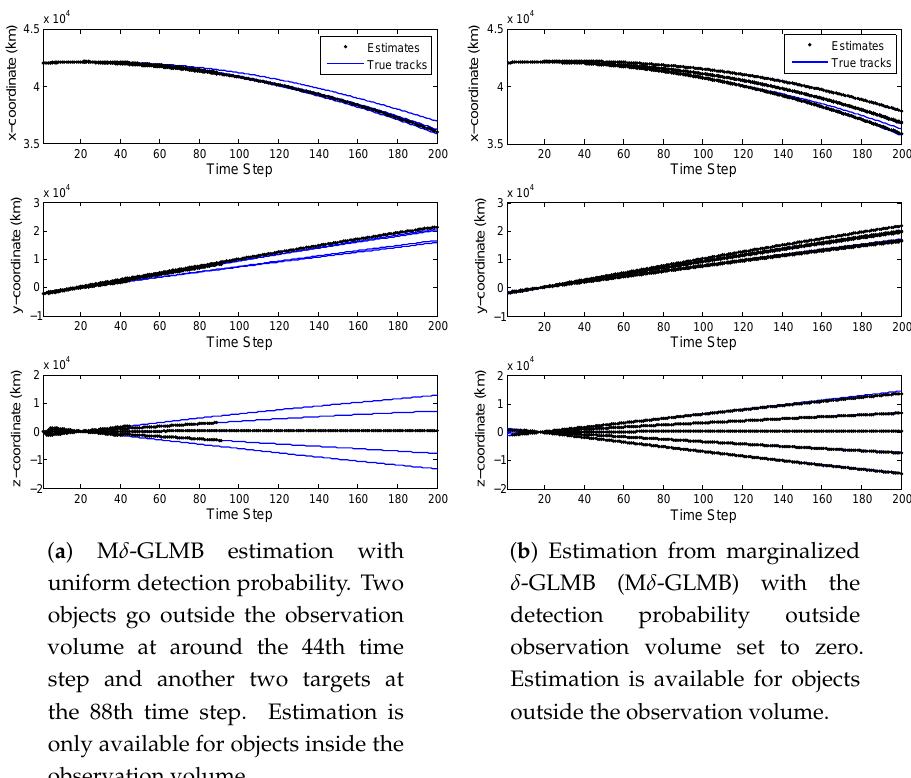
Figure 4. Estimation with different detection probability